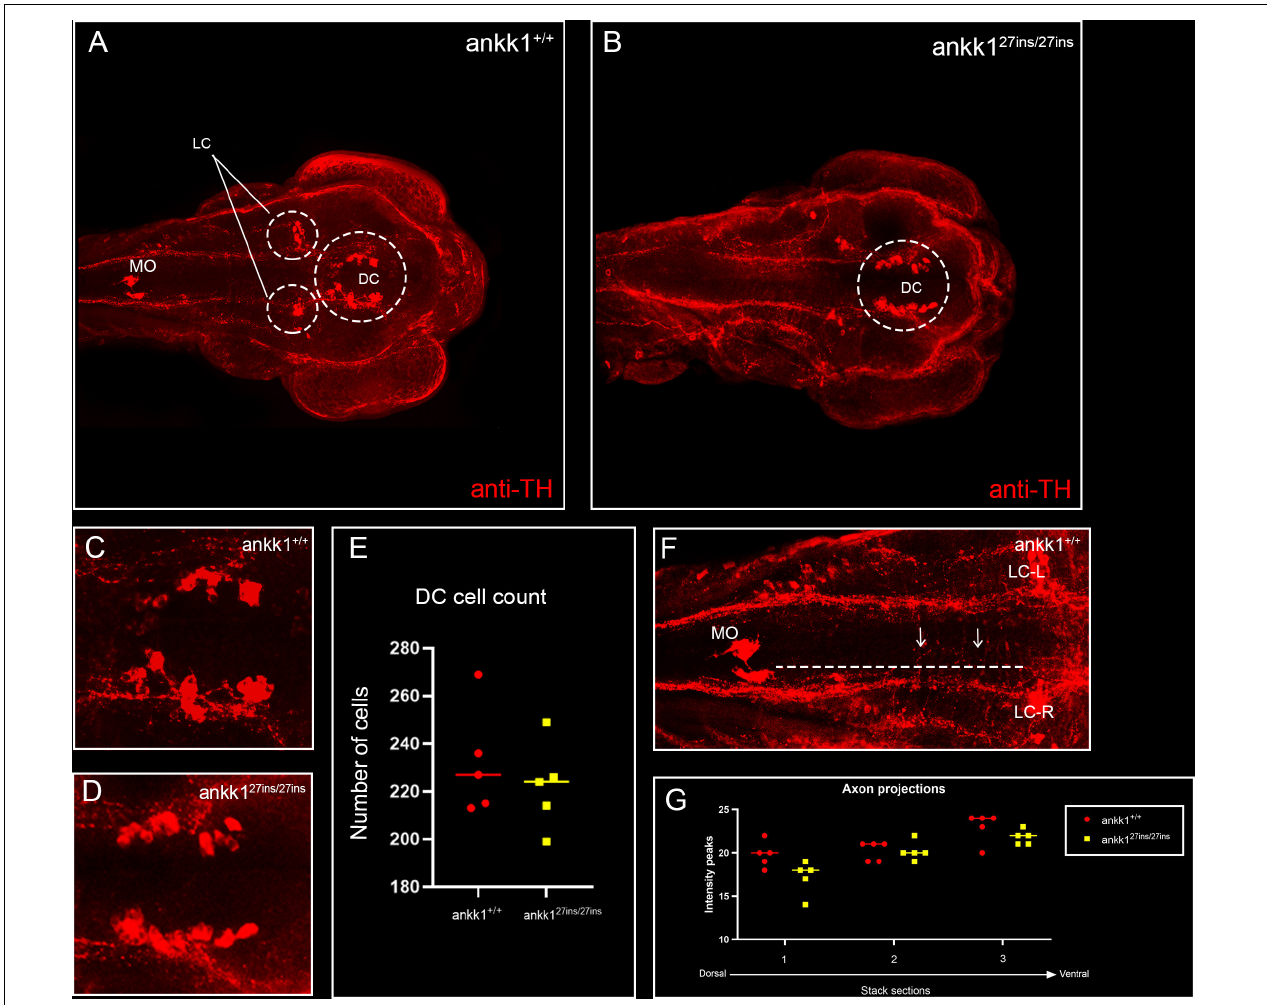
FIGURE 6 | Anti-tyrosine hydroxylase (TH) immunolabeling on 3 days post fertilization zebrafish larvae. (A,C) ankk1 + / + and (B,D) ankk1 27 ins / 27 ins . (A,B) Maximum projection dorsal view of whole mount larvae. Circles indicate diencephalic dopaminergic cluster (DC), used for quantification of cell number (E) , and locus coeruleus (LC) used as landmark for determining the extent of the medial longitudinal catecholaminergic tract when quantifying the number of anti-TH labeled projections to the midline (F,G) . (C,D) Representative images of staining of DC used for cell quantification shown in (E) . (F) Example of sections used for quantification of dopaminergic projections shown in (G) . Projections were assessed from posterior to anterior using the LC and anterior extent of the medulla oblongata (MO) as landmarks [ (F) dotted line, arrows indicate example of projections], and from dorsal to ventral [ (G) stacks 1–3]. N = 5 samples × genotype